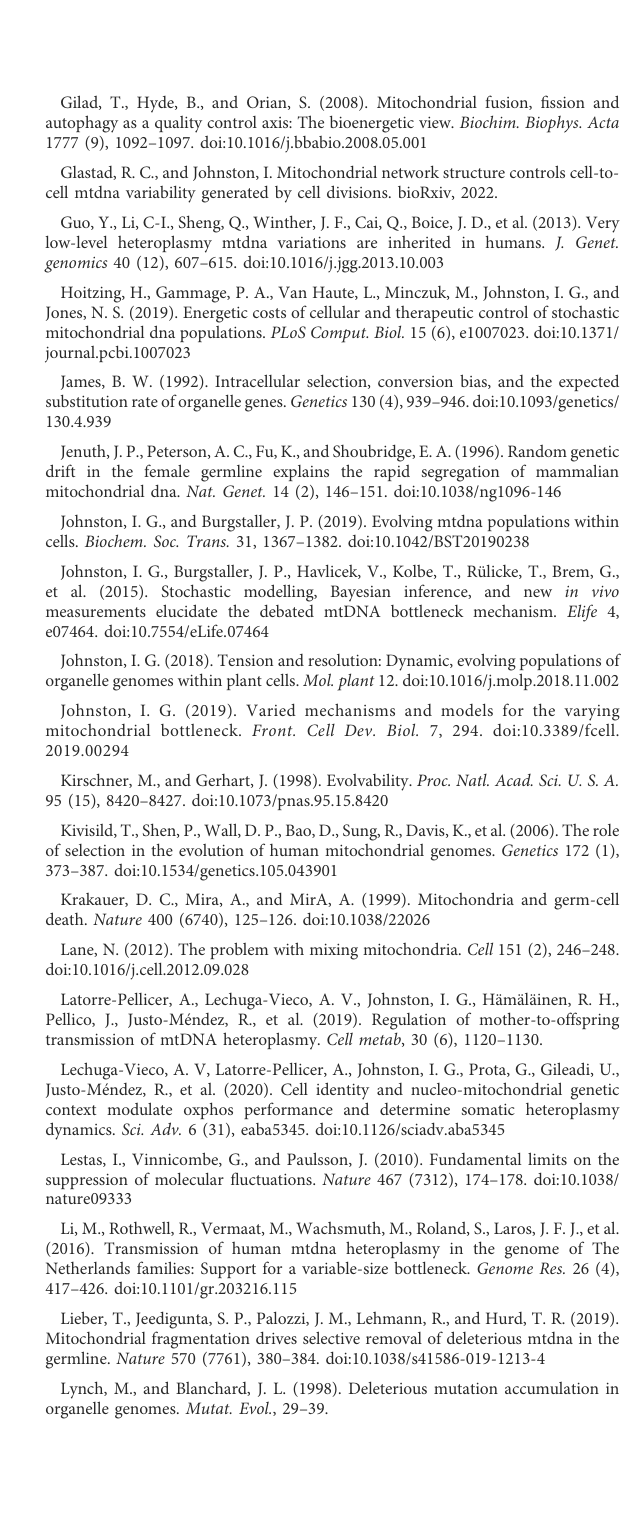
( fi xed penalty ε for h > 0.1). As before, adaptation is facilitated by higher segregation strength (right). SUPPLEMENTARY FIGURE S5 Evolution of the bottleneck under fi xed mutation rates. Segregation strength σ emergingfromevolutionarysimulations(asinthemaintext)in fl uctuating environments, for different fi xed mutation rate µ and fi tness penalty ε . At lower µ , stronger segregation evolves to